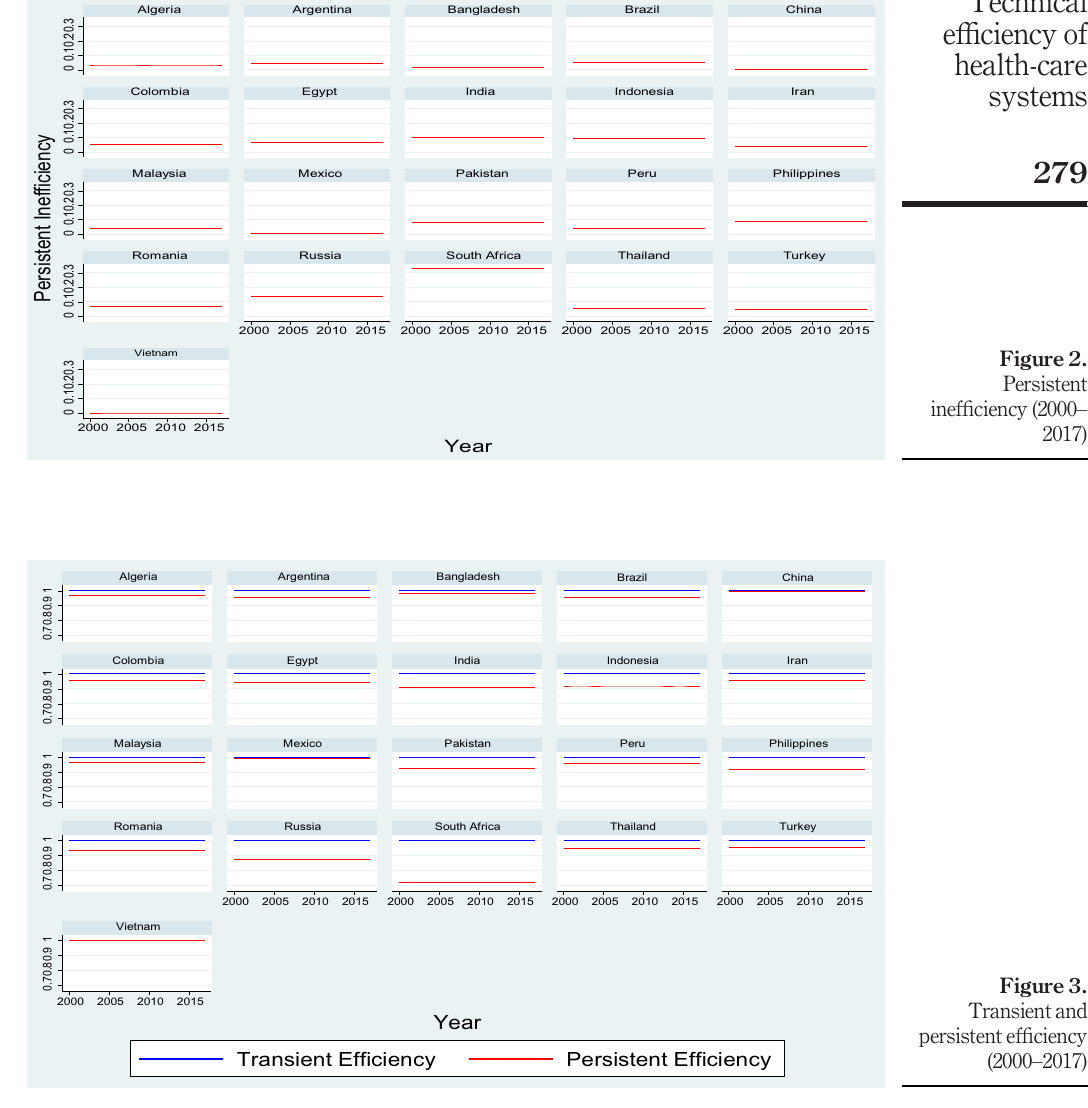
Figure 3. Transient and persistent ef fi